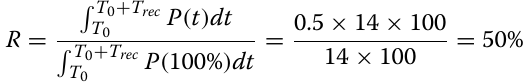
10 MPa; ε tu 0.3%; σ tu 14 = = =